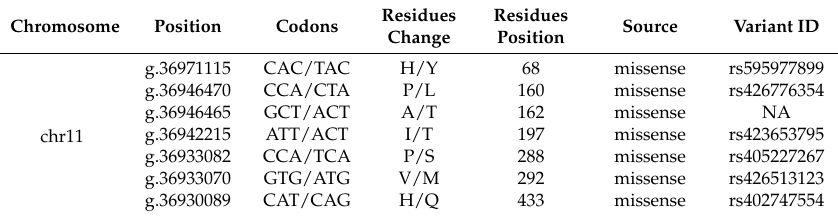
Table 1. SNPs for missense in the ovine B4GALNT2 gene. Residues Chromosome Position Codons Change